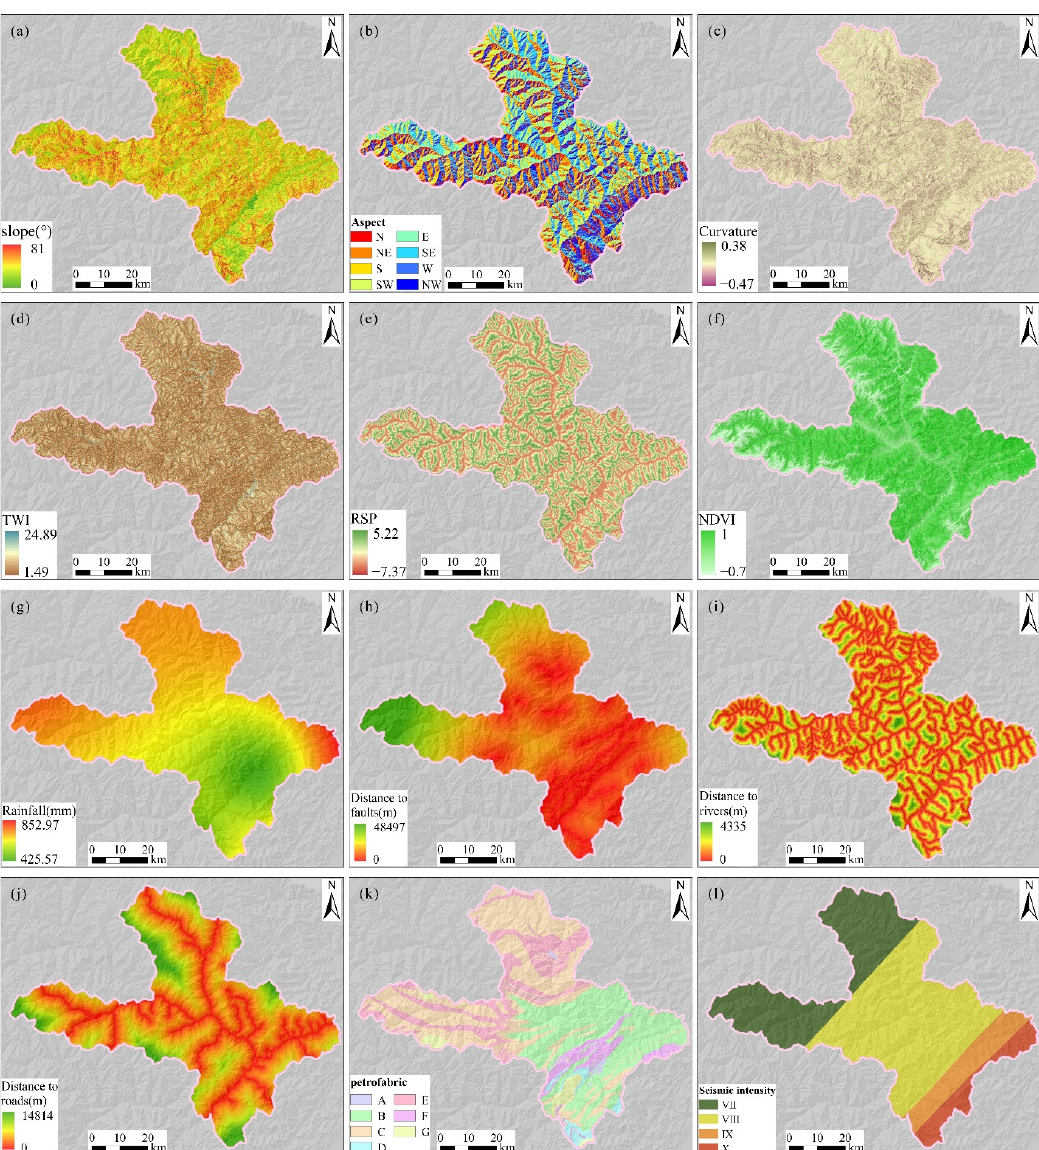
Figure 4. Grid map of the evaluation factors in the study area: ( a ) Slope gradient; ( b ) slope aspect; ( c ) Curvature; ( d ) topographic wetness index (TWI); ( e ) relative slope position (RSP); ( f ) normalized difference vegetation index (NDVI); ( g ) Rainfall; ( h ) Distance to faults; ( i ) Distance to rivers; ( j ) Distance to Roads; ( k ) Petrofabric; ( l ) Seismic intensity.